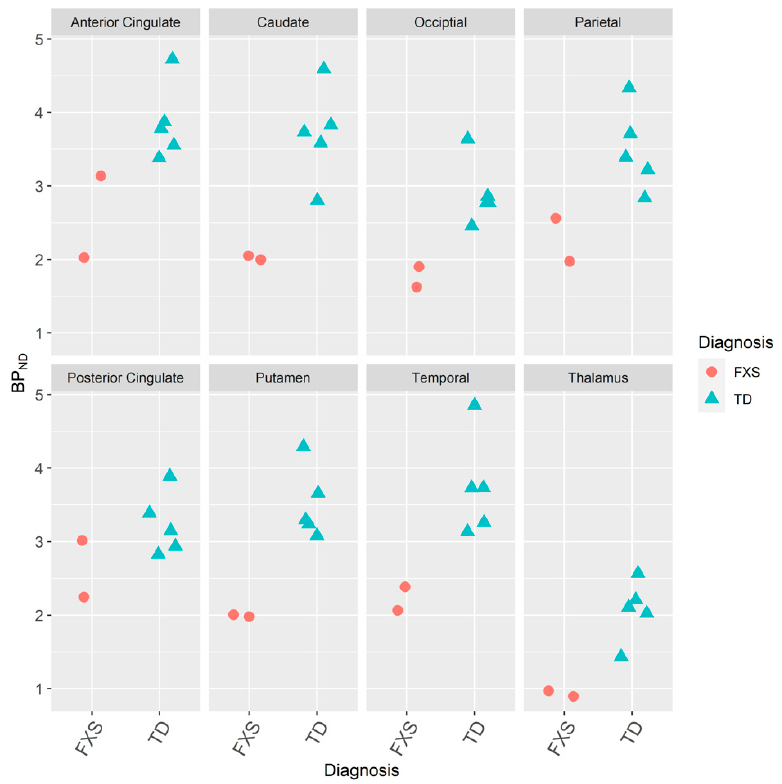
Figure 3. Dot plot of non-displaceable binding potential (BP ND ) [32] images by reference tissue graphical analysis (RTGA) [76,77] of volumes of interest on positron emission tomography (PET) for 90 min of participants with FXS and ID ( N = 2) and TD ( N = 5) who received intravenous bolus injections of 185 MBqs (5 mCis) of [ 18 F]FPEB [25,30,55,79].